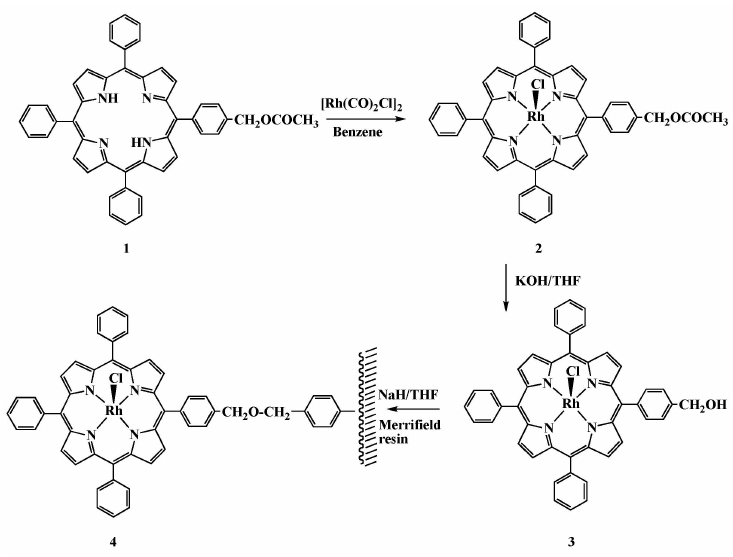
Figure 1. Synthetic pathway for obtaining the catalyst 4